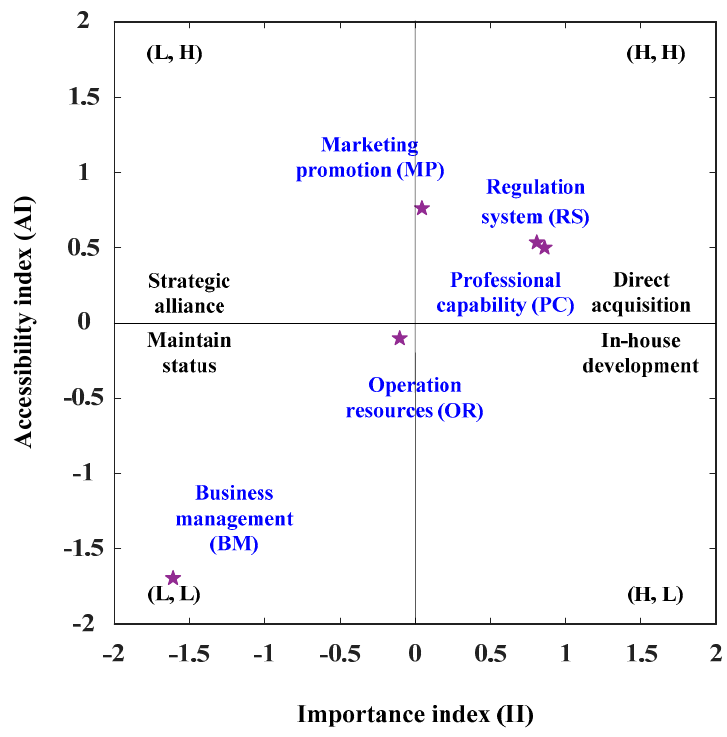
Figure 1. The analysis map of IAA (Importance Accessibility Analysis).